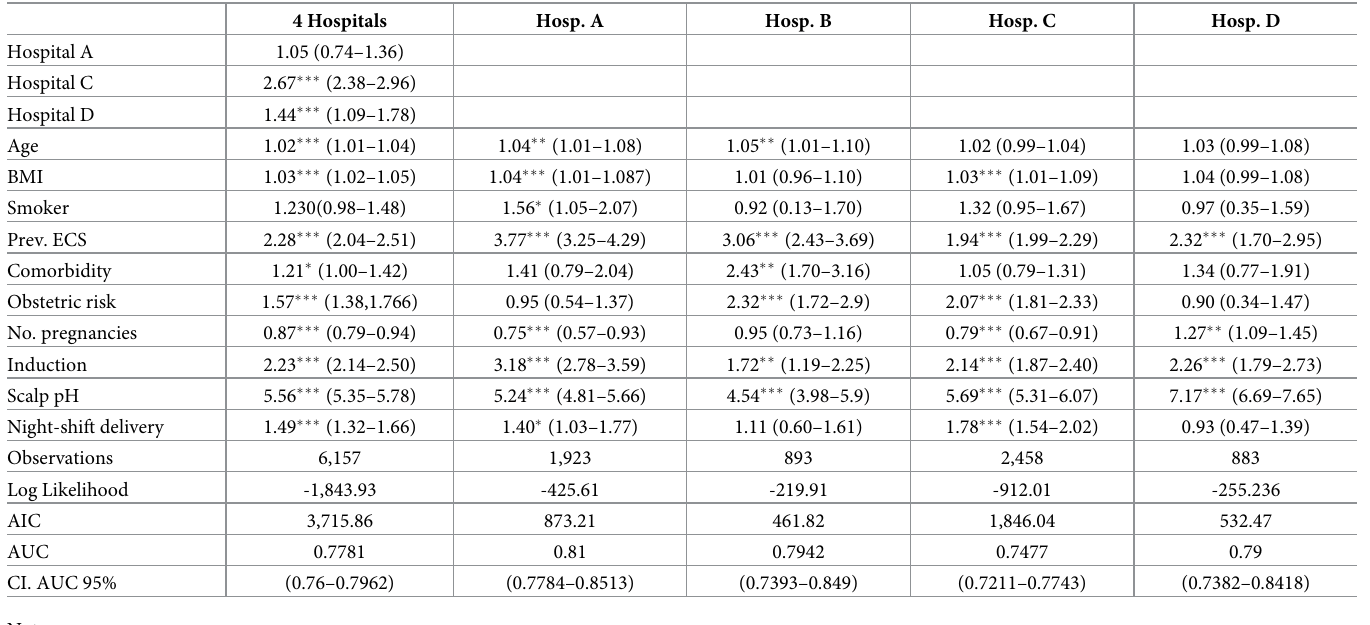
Table 6. Logistic regression models to assess the association between the putative risk factors and type of delivery for the overall population and the four